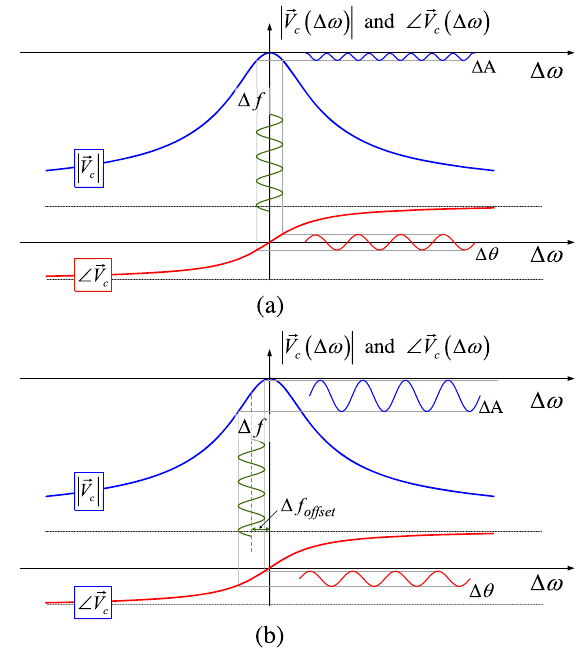
cavity as a function of detuning ( Δ ω ¼ ω 0 − ω ) in the case